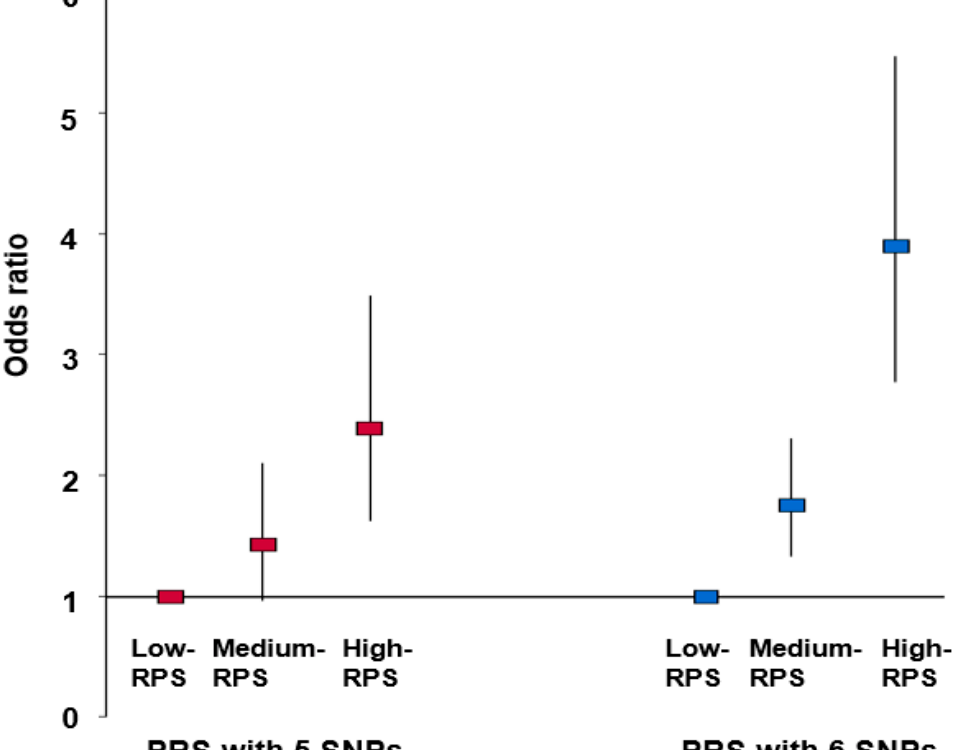
Figure 2. Adjusted odds ratio (OR) and 95% confidence intervals (CIs) of polygenetic risk score (PRS) with 5 SNPs and 6 SNPs generated by SNP–SNP interaction for the thyroid cancer risk. PRS with five SNPs and six SNPs, the best model of GMDR, was calculated by the summation of the number of risk alleles of five and six SNPs, and the calculated PRS were divided into three categories (0–3, 4–5, and ≥ 6) and (0–3, 4–6, and ≥ 7) by tertiles, respectively, as the low-PRS, medium-PRS, and high-PRS groups. Adjusted OR was analyzed by logistic regression with the covariates including age, gender, residence area, survey year, body mass index, education, income, menopause, initial menstruation, smoking, alcohol, energy, physical activity, fat percent intake, and carbohydrate percent intake. The reference group was the low-PRS in logistic regression. Red and blue boxes indicated the adjusted ORs for five SNPs and six SNPs, respectively, and the lines through red and blue boxes indicated 95% CI.